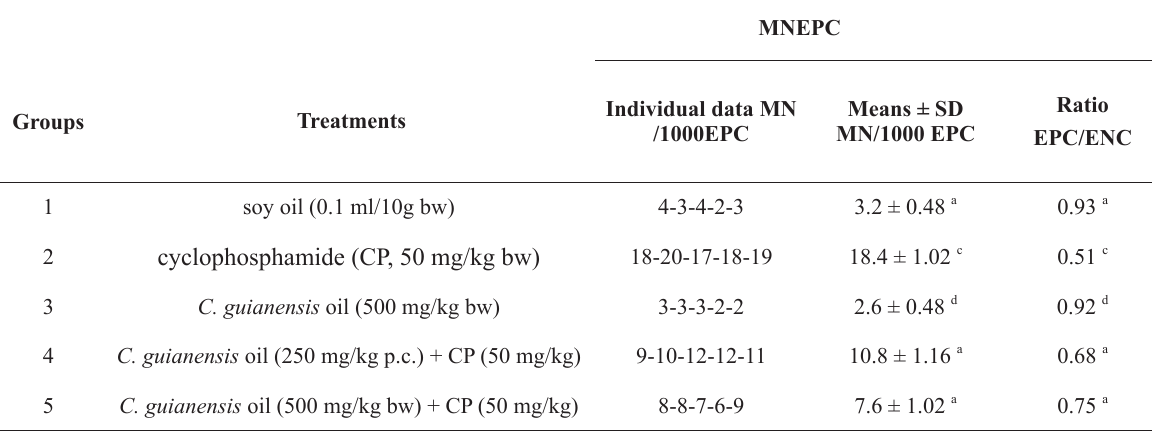
MMPCE frequency compared to the PCE/NCE ratio in bone marrow cells of mice pre-treated with C. guianensis oil by five days and after exposed to